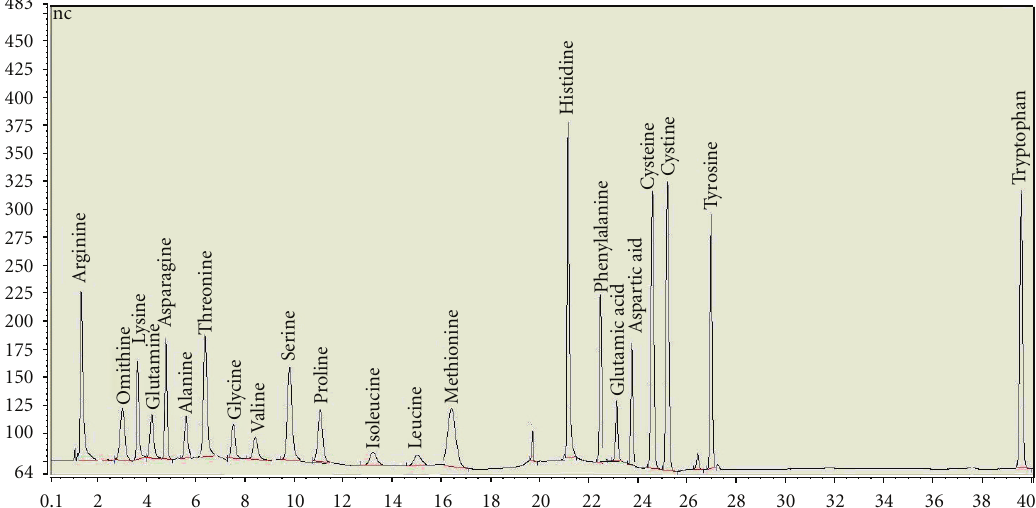
Figure 1: IC chromatogram of 22 amino acids standard solution: (1) arginine; (2) omithine; (3) Lysine; (4) glutamine; (5) asparagine; (6) alanine; (7) threonine; (8) glycine; (9) valine; (10) serine; (11) proline; (12) isoleucine; (13) leucine; (14) methionine; (15) histidine; (16) phenylalanine; (17) glutamic acid; (18) aspartic aid; (19) cysteine; (20) cystine; (21) tyrosine; (22) tryptophan.